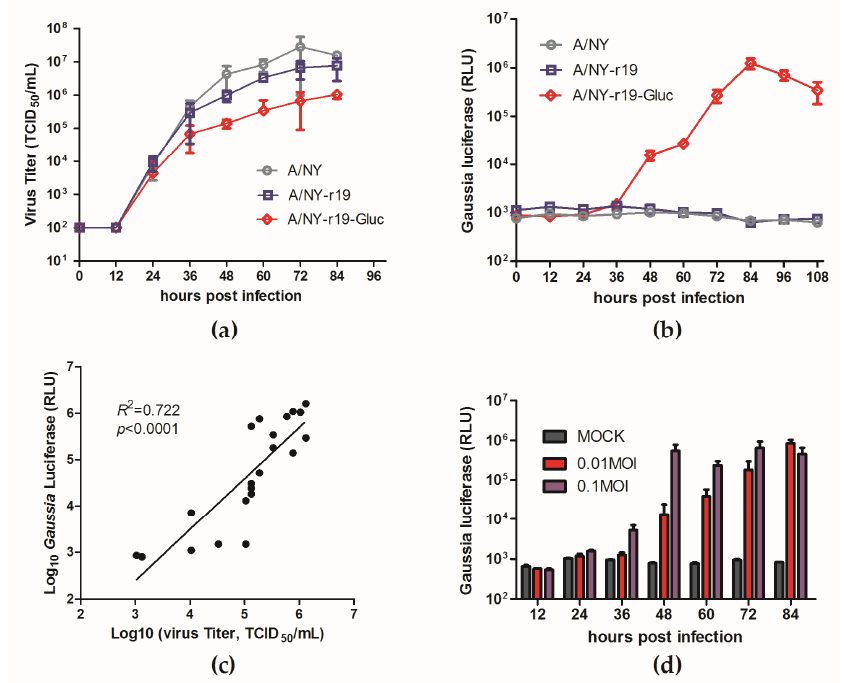
Figure 4. In vitro characterization of NY-r19-Gluc virus. ( a – c ) Madin-Darby canine kidney (MDCK) cells were infected with A / NY-r19–Gluc, A / NY-r19, and influenza A virus (IAV) NY at a multiplicity of infection (MOI) of 0.01. At indicated times post-infection, ( a ) viral titers and ( b ) Gaussia luciferase activities were respectively determined. ( c ) Correlation between supernatant luminescence and infectious virus titers ( R 2 = 0.722, p < 0.0001; GraphPad Prism 5, La Jolla, CA, USA). ( d ) Gaussia luciferase signals derived from supernatants of NY-r19-Gluc virus-infected cells at MOIs of 0.01 and 0.1, respectively.